Question: Compose a caption that would accompany this figure in a paper.
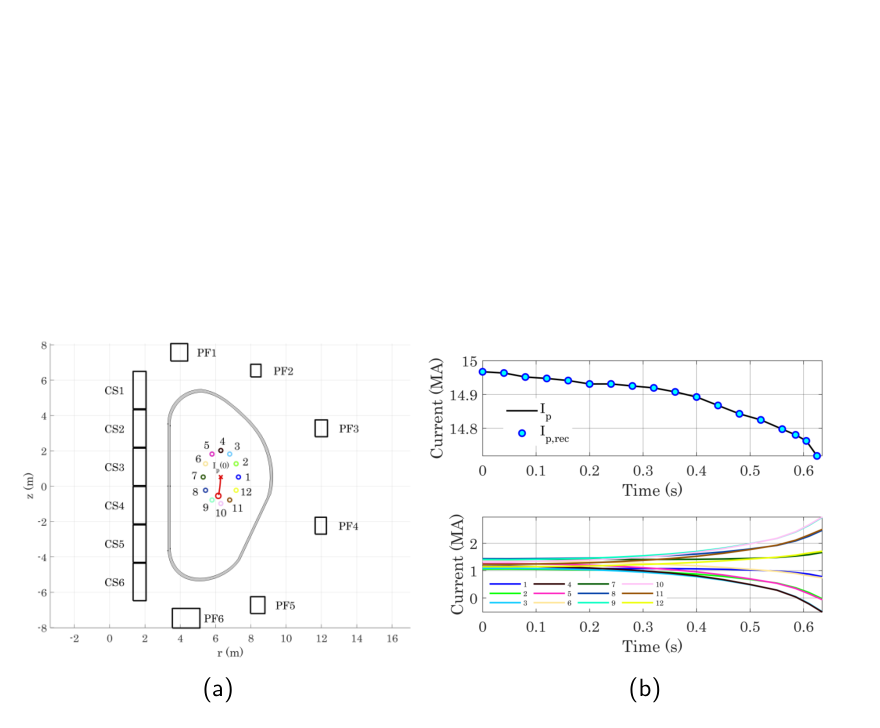
Answer: (a) Cross section of axisymmetric VV. Set of CS coils, and PF coils. The position of the plasma centroid at t = 0 is marked with the red cross, while that at t = 0.63 s with the red circle. The trajectory is also drawn. The equivalent current loops mimicking the plasma centroid movement are labeled with circular marks from 1 to 12. (b) The trend of plasma current Ip(t) and that of equivalent current loops.